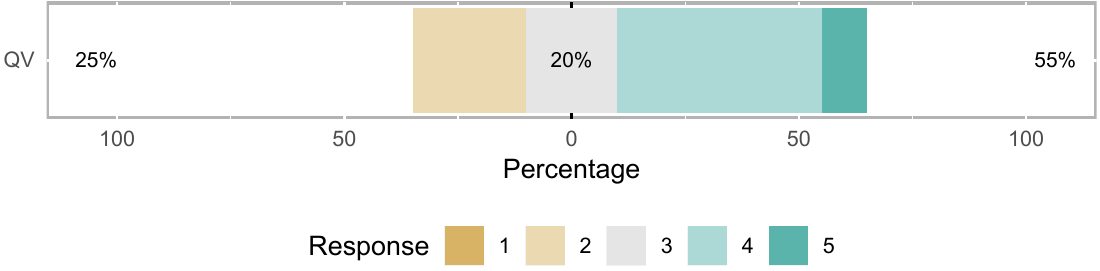
Figure 12. A plot showing the distribution of the answers for the question QVin Experiment